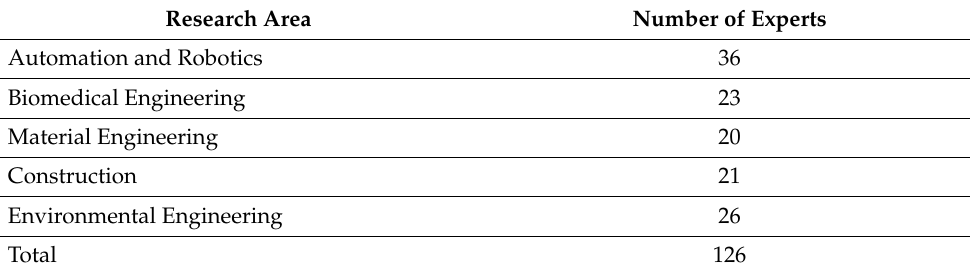
Table 4. Experts involved in